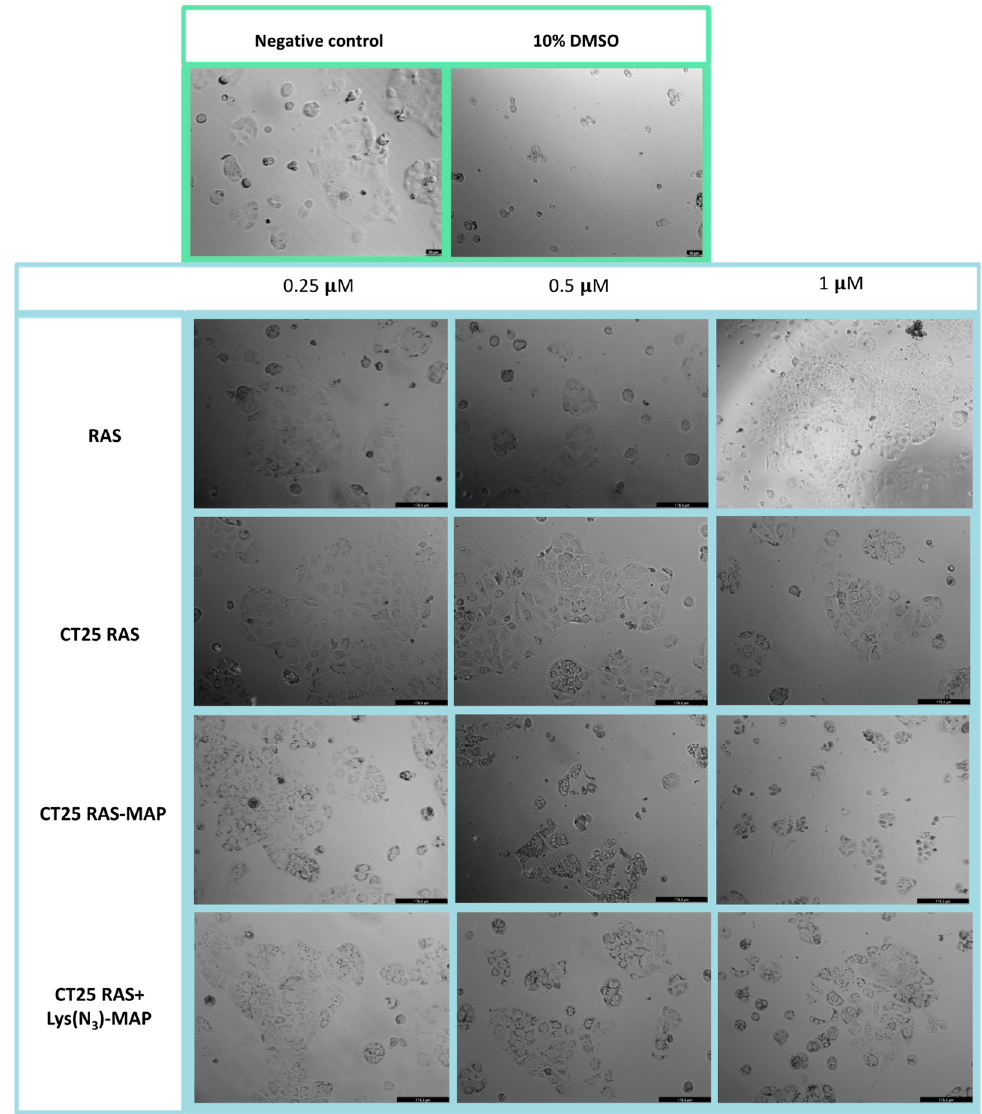
Figure 6. Microscope cellular visualization through Leica DFC350 FX of treatment with negative control (ultra-purified H 2 O), positive control (10% DMSO), free drug, and NLC-loaded formulations ((CT25RAS, CT25RAS-MAP and CT25 RAS + Lys(N 3 )-MAP) on Caco-2 cell line at concentrations of 0.25, 0.5, and 1 μ M.